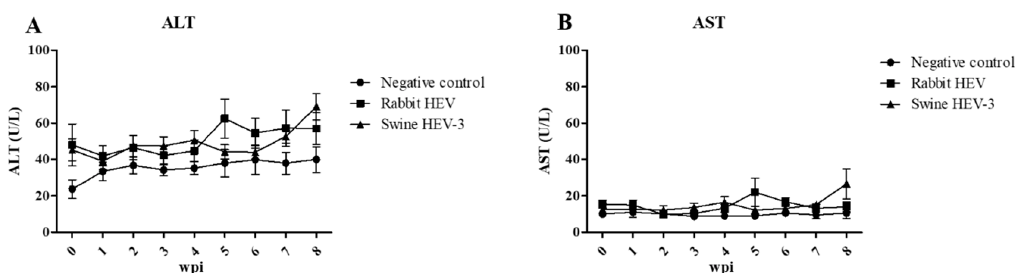
Figure 2. Determination of hepatic enzyme levels. ( A ) ALT and ( B ) AST levels measured by UV-assay at 0–8 wpi in HEV-infected rabbits versus non-infected control rabbits.